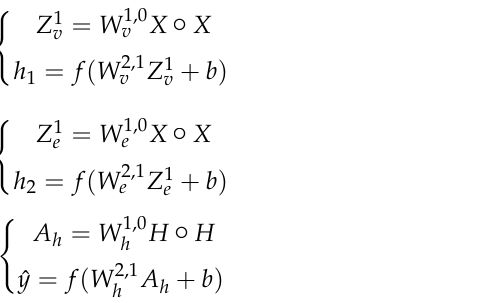
Figure 2. Dendrite